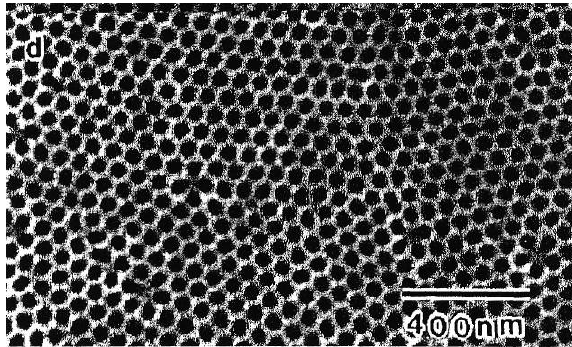
Figure 4. Self-ordered porous alumina template formed under 27 V anodizing potential. Image taken from (reproduced by permission of The Electrochemical Society